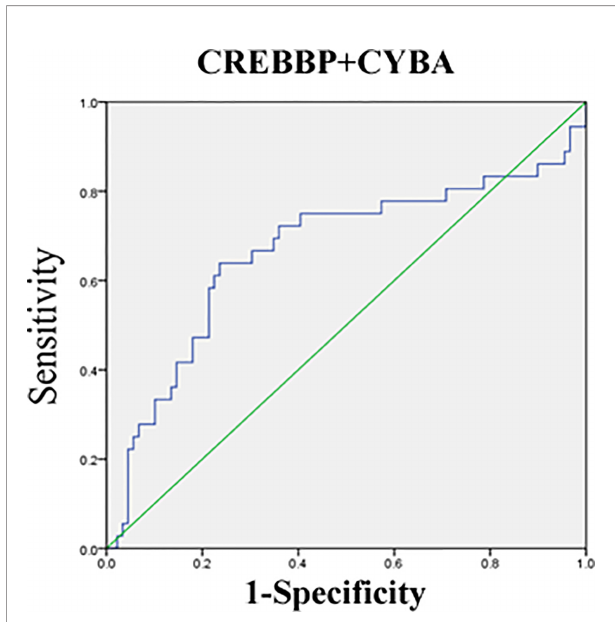
FIGURE 6 | Receiver-operating characteristic (ROC) curves for distinguishing SR and SS using the combination of CREBBP and